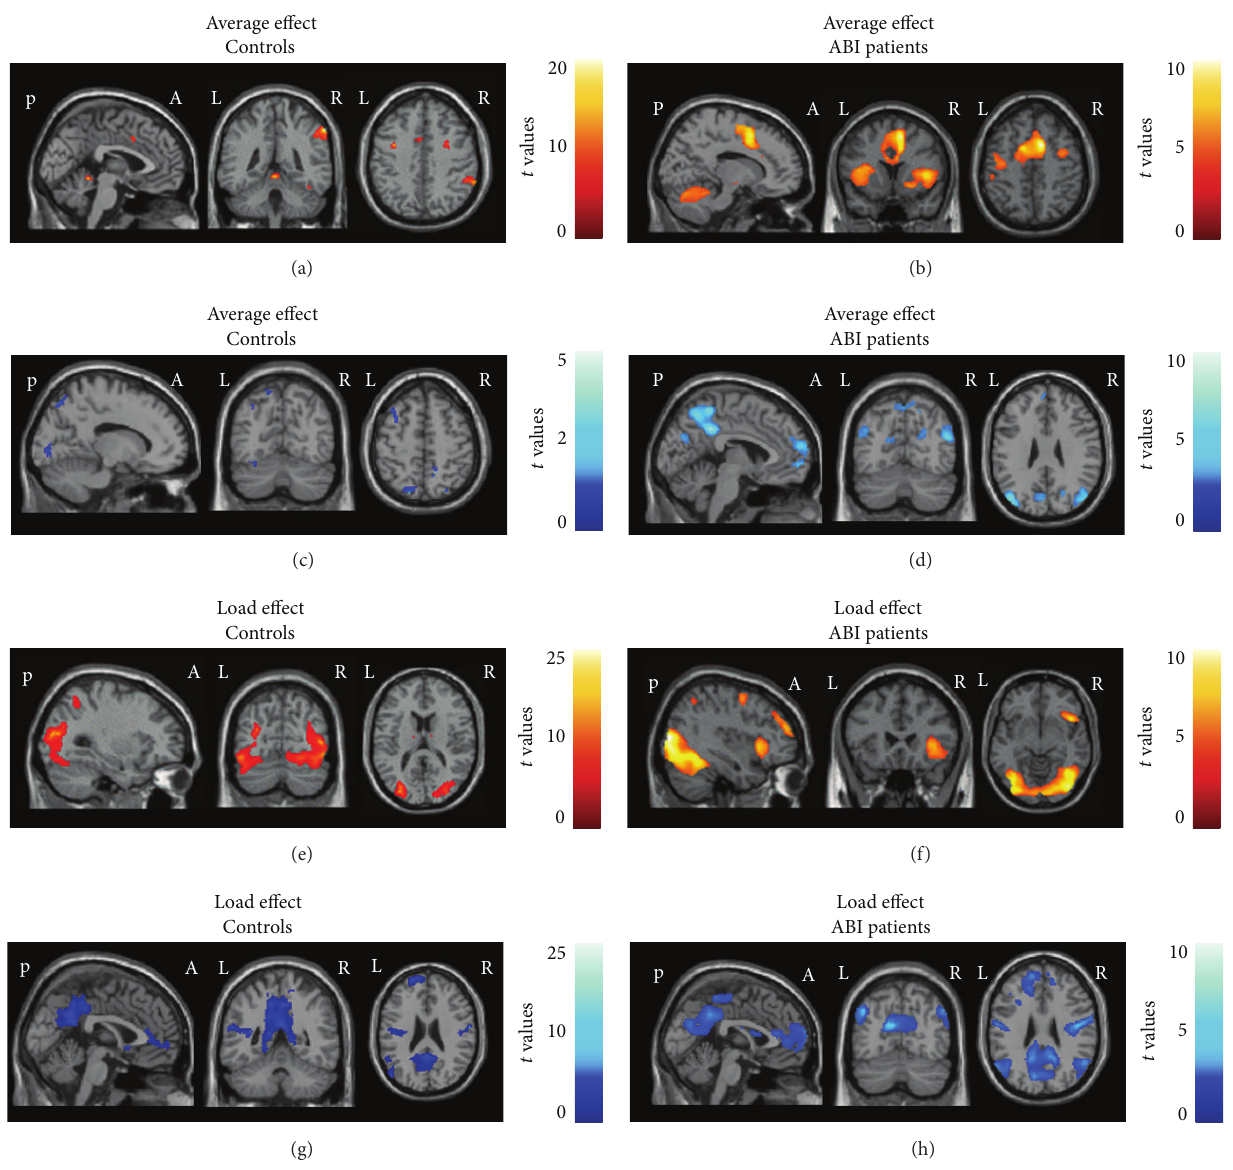
Figure 1: Brain regions showing significant activation (colour coded with red-yellow scales) and deactivation (colour coded with blue-light blue scales) during fMRI with the modified Conners Continuous Performance Test (CCPT) (average condition and load effect) in healthy controls and patients with acquired brain injury (ABI). (a) and (c) Average activation and deactivation in healthy controls; (b) and (d) average activation and deactivation in ABI patients; (e) and (g) activation and deactivation during the load effect in healthy controls; (f) and (h) activation and deactivation during the load effect in ABI patients. Results are shown at 𝑝 < 0.001 , uncorrected. Images are in neurological convention. See text for further